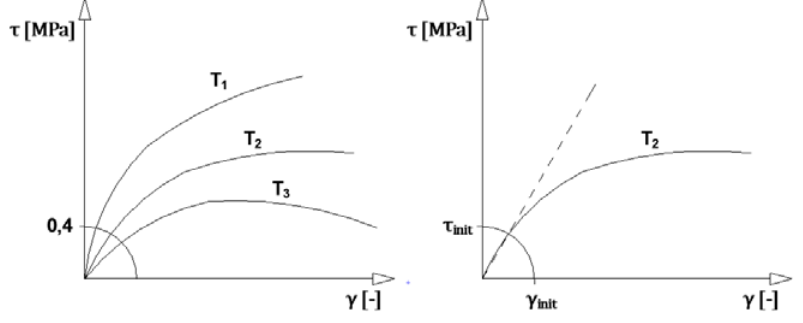
Fig. 6 Initial shear modulus evaluation where the temperatures T 1 > T 2 > T 3 .